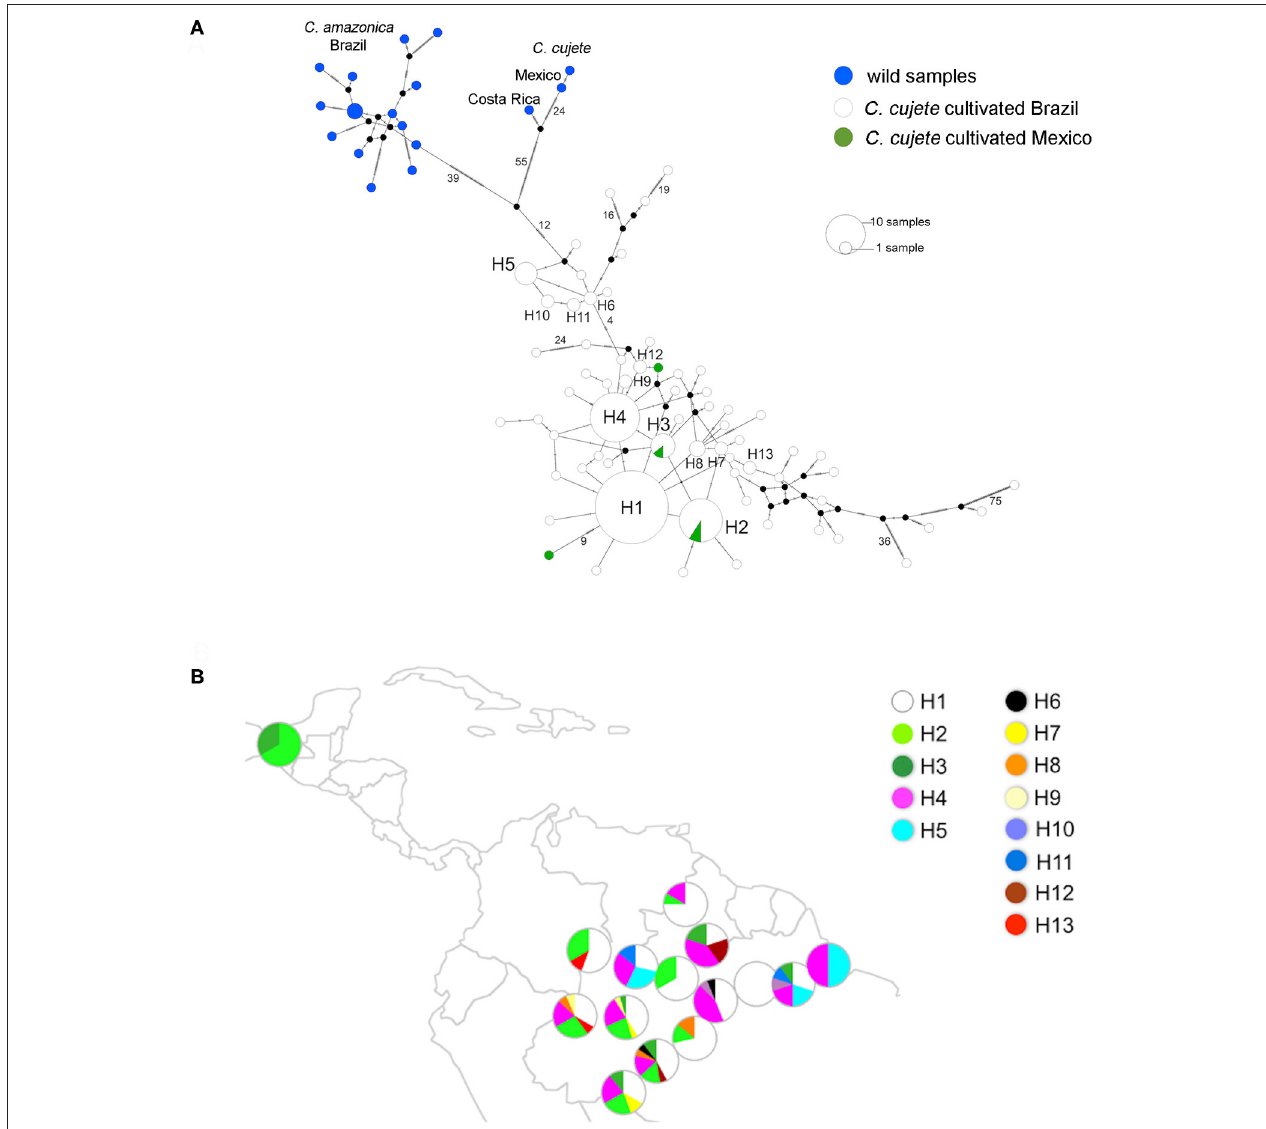
FIGURE 4 | Chloroplast diversity of 215 cultivated and wild treegourds ( Crescentia cujete ; C. amazonica ) from Brazilian Amazonia and Mesoamerica based on 334 SNPs. (A) Haplotype median-joining network of wild samples from Mexico and Costa Rica ( C. cujete ) and Brazil ( C. amazonica ), and cultivated C. cujete from Brazil and Mexico. The most abundant haplotypes are H1–H5 and the rare haplotypes, which are shared between at least two samples, are H6–H13. Number of substitutions between haplotypes is indicated on the branches. Black dots represent hypothetical intermediate haplotypes (B) Geographic distribution of 13 haplotypes of cultivated C. cujete depicted in the network (H1–H13). The area of the pie-slice is proportional to relative frequency of each haplotype in the section (upper, middle, lower) of Amazonian rivers and in